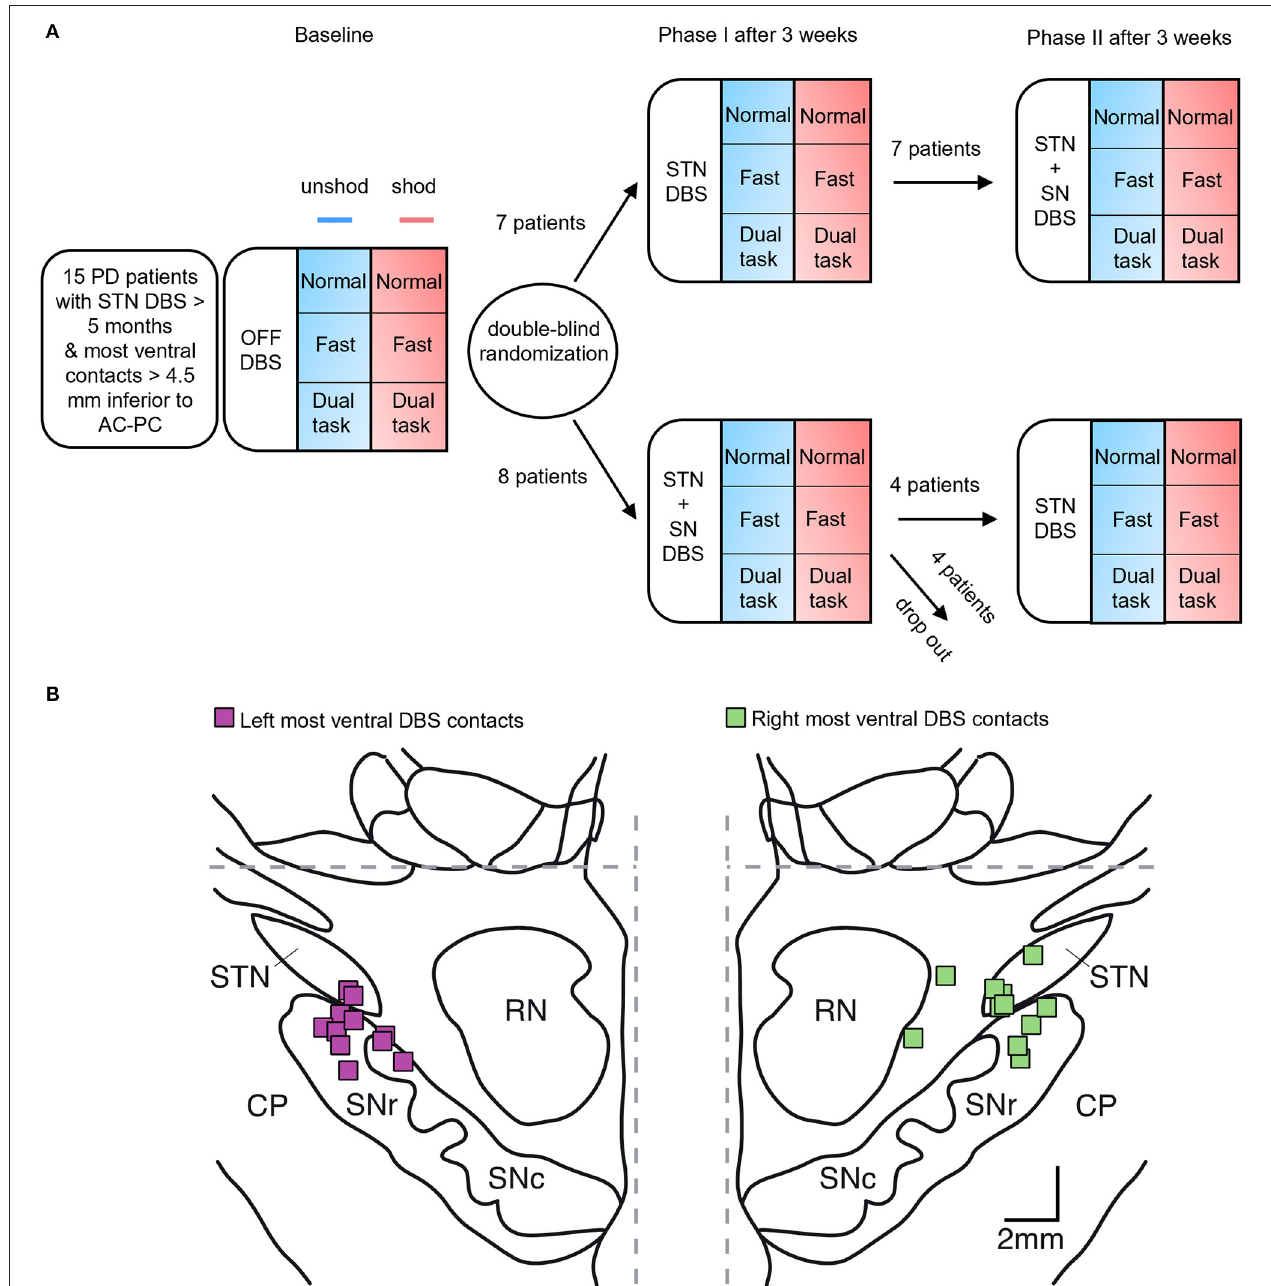
FIGURE 1 | Experimental setting. (A) Study design: randomized crossover trial over 6 weeks. At baseline, patients were evaluated in the STIM OFF mode. Spatiotemporal parameters of gait were measured under six paradigms in randomized order: the three gait tasks were performed at normal pace, at a fast pace, and in a dual-task setting either shod (red squares) or unshod (blue squares), followed by the other footwear condition. After baseline assessment, patients with Parkinson’s disease (PD) were assigned in phase I to either conventional deep brain stimulation of the subthalamic nucleus (STN DBS) or combined STN and substantia nigra (STN + SN) stimulation in a double-blind randomized order. After 3 weeks, patients were switched to the other stimulation mode for the next 3 weeks. Of note, four patients with PD programmed in STN + SN DBS withdrew within the first week and terminated the study prematurely. (B) stereotactic reconstruction of 11 patients included in statistical analysis: squares indicate the localization of the most ventral DBS electrode contacts for the left and right hemisphere, on frontal sections of the stereotactic atlas of Morel (2007), at a level 5mm behind midcommissural point. Interrupted gray lines denote midline and anterior and posterior commissure (AC-PC) level, respectively. CP, cerebral peduncle; RN, red nucleus; SNr, substantia nigra pars reticulata; SNc, substantia nigra pars compacta; STN, subthalamic nucleus.